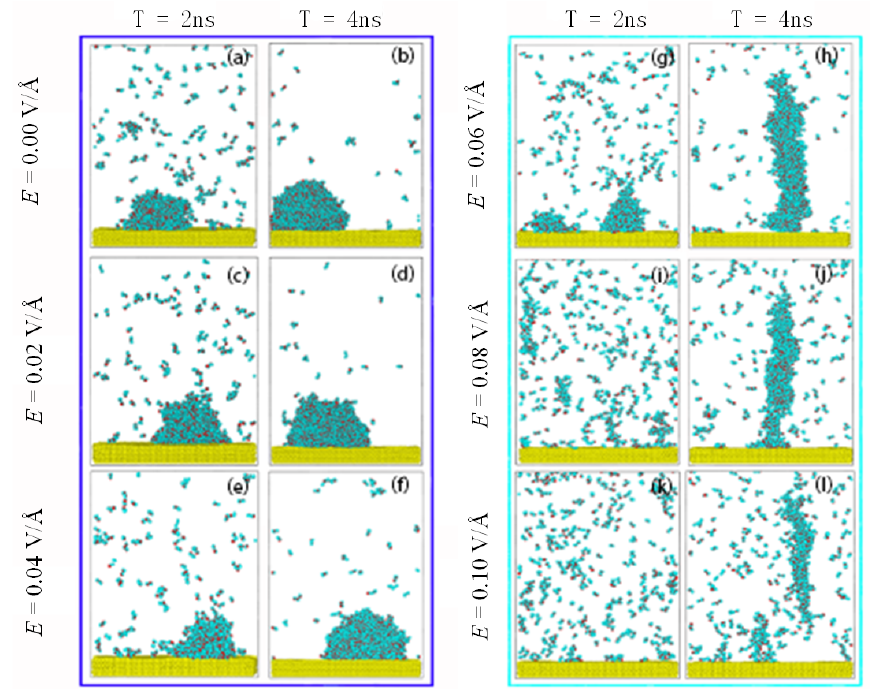
Figure 3. Snapshots of condensation of water molecules on the surface at 2 ns and 4 ns, under an electric field. ( a ) 2 ns, ( b ) 4 ns at E = 0.00 V/Å; ( c ) 2 ns, ( d ) 4 ns at E = 0.02 V/Å; ( e ) 2 ns, ( f ) 4 ns at E = 0.04 V/Å; ( g ) 2 ns, ( h ) 4 ns at E = 0.06 V/Å; ( i ) 2 ns, ( j ) 4 ns at E = 0.08 V/Å; ( k ) 2 ns, ( l ) 4 ns at E = 0.10 V/Å. Nanomaterials 2019 , 9 , x FOR PEER REVIEW